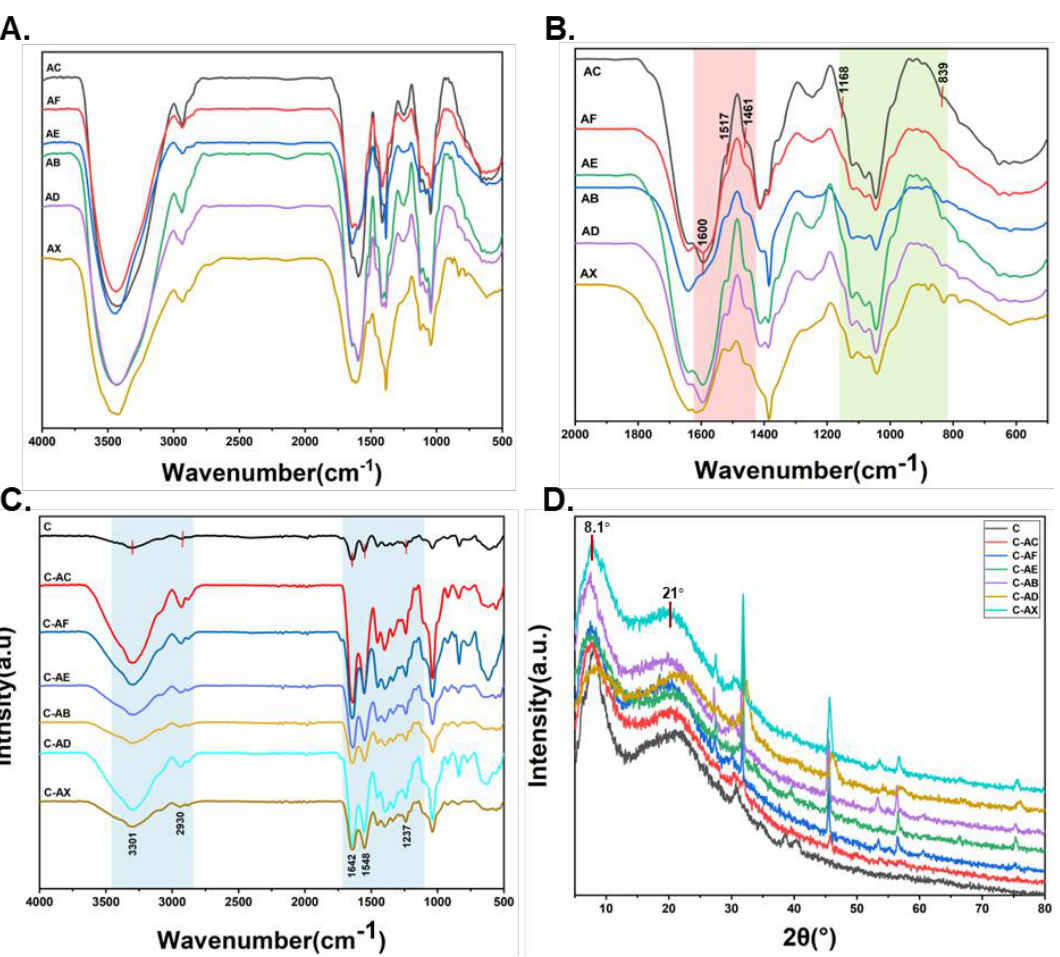
Figure 3. ATR−FTIR spectrum ( A – C ) and X-ray diffraction spectrum ( D ) of APL with collagen films. ( A ): wavenumber from 500 to 4000 cm −1 of the different fungi-modified APL; ( B ): wavenumber from 500 to 2000 cm −1 of the different fungi-modified APL; ( C ): wavenumber from 500 to 4000 cm −1 of the different fungi-modified APL with collagen film. C (collagen film); C−AC (collagen with none−modified APL film); C−AF (collagen with C. echinulate FR3−modified APL film); C−AE (collagen with G. lucidum EN2−modified APL film); C−AB (collagen with P. ostreatus BP3−modified APL film); C−AD (collagen with S. commune DS1−modified APL film); C−AX (collagen with Xylariaceae sp. XY−modified APL film).